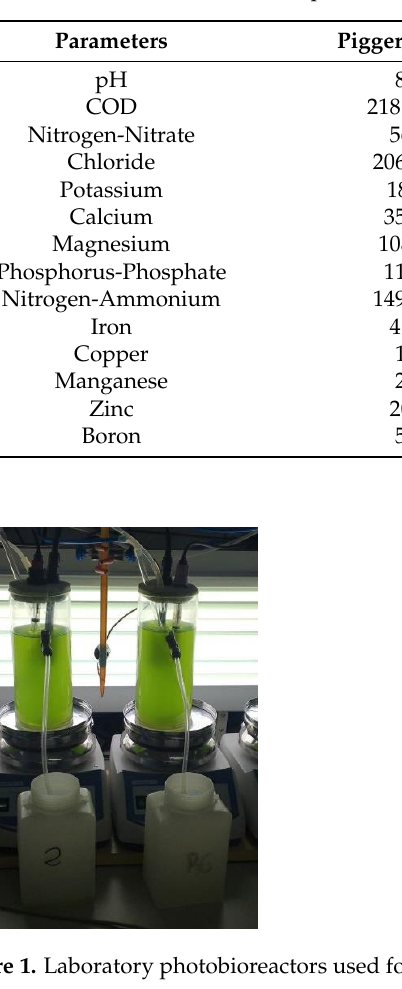
Table 1. Average compositions of the culture medium and piggery wastewater used as the influent in the bioreactors. Concentrations expressed as mg × L − 1 .